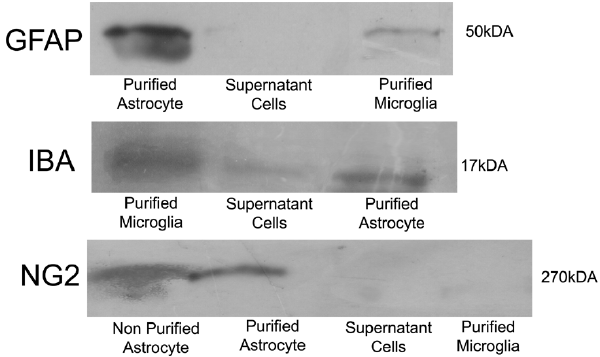
FIGURE 5 - The bands of GFAP (upper panel), IBA1 (middle panel) and NG2 (lower panel) proteins detected in pimary cultured cells from mouse spinal cord by means of Western blot technique. The GFAP, IBA1 and NG2 bands were about 50 kDA, 17 kDA and 270 kDA, respectively. Figure illustrate the bands of GFAP (protein of the intermediate filament of the astroglial cytoskeleton), IBA1 (a calcium modulator that is shown to be expressed in microglia) and NG2 (a glycoprotein detected in oligodendrocyte/astrocyte